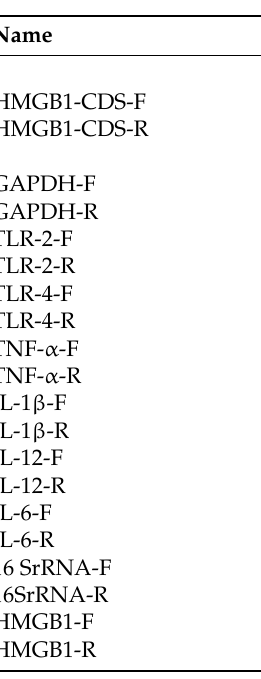
Table 1. Sequences of DNA primers.